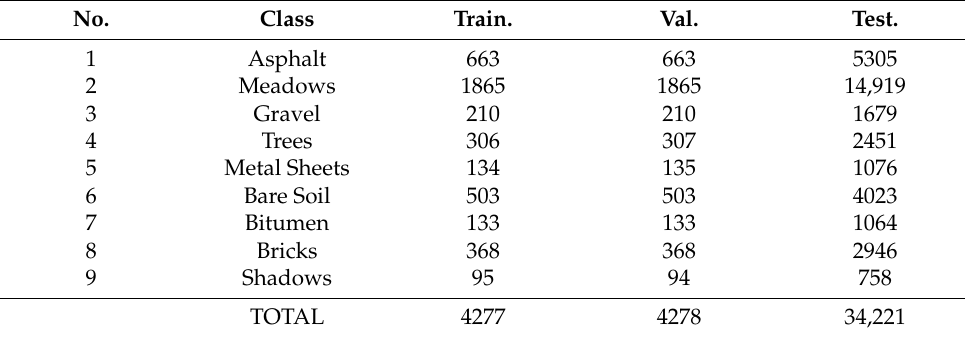
Table 2. Training, validation, and testing numbers in the Pavia University dataset.